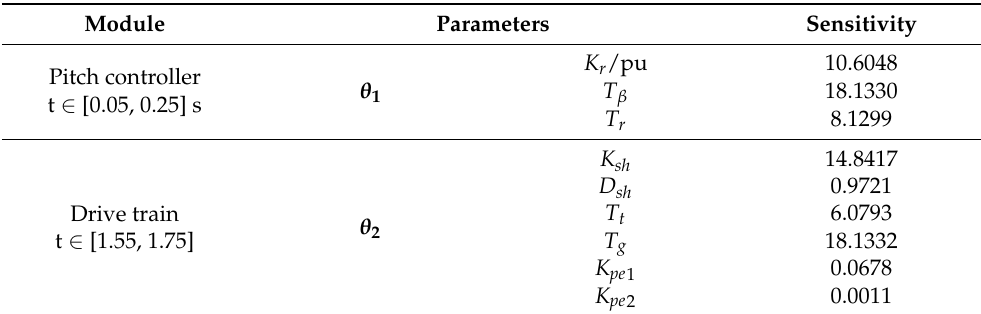
Table 2. PSD sensitivities of each parameter.